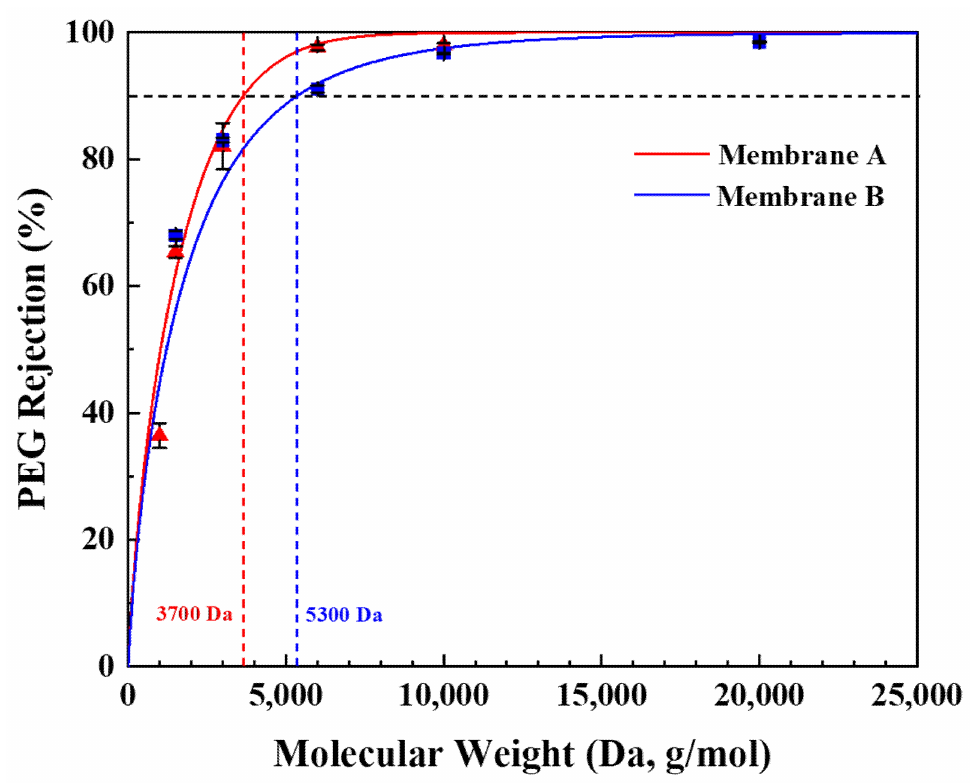
Figure 7. PEG retention curves of the γ -Al 2 O 3 membrane A and